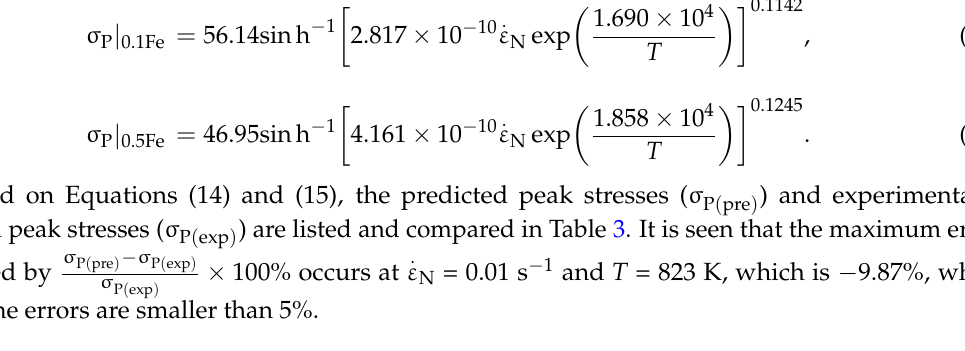
Table 2. Material parameters of the Fe-containing recycled Al alloys. Al Alloys